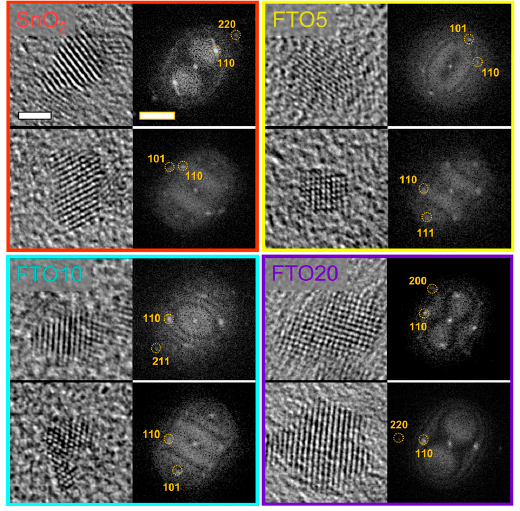
Figure 2. High resolution transmission electron microscopy (TEM) images of doped and undoped SnO 2 NCs. For each sample, two images of individual NCs and the respective fast Fourier transform (FFT) images are presented. The scale bars are 2 nm for the TEM images and 2 × 1/nm for the FFT